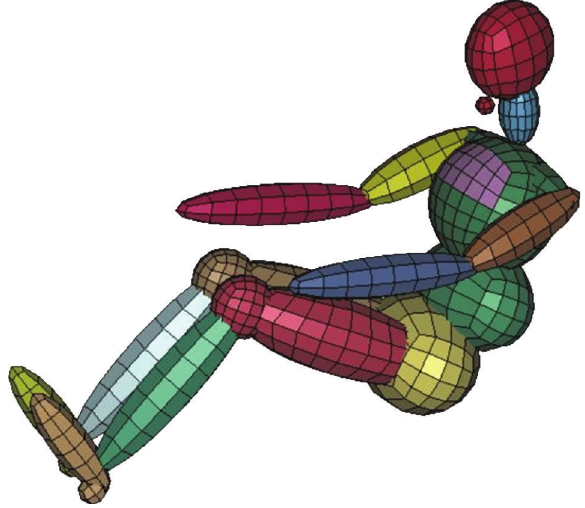
Figure 3: A rigid body dummy model representing a crew member in a blast event simulation.